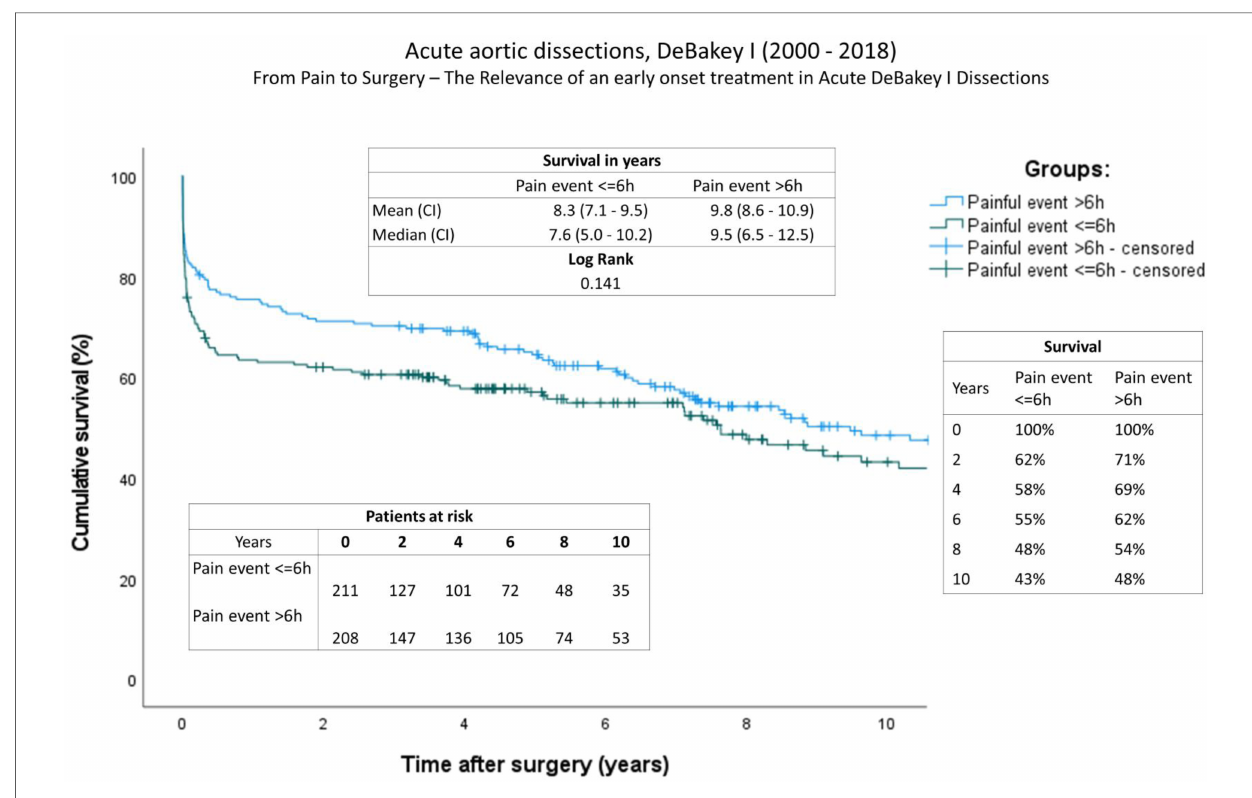
FIGURE 1 Survival: Kaplan-Meier curves showing survival of both groups (onset of pain <6 h; onset of pain >6 h). The x-axis denotes the time after